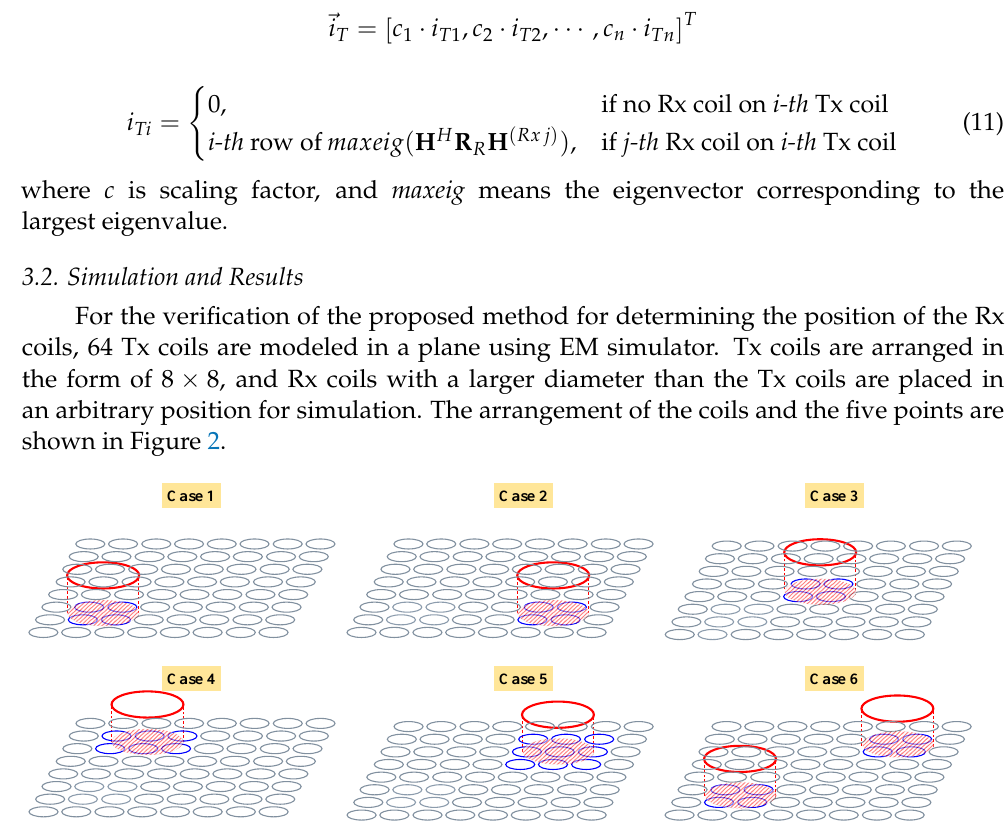
Figure 2. Simulation model for estimating Rx coils